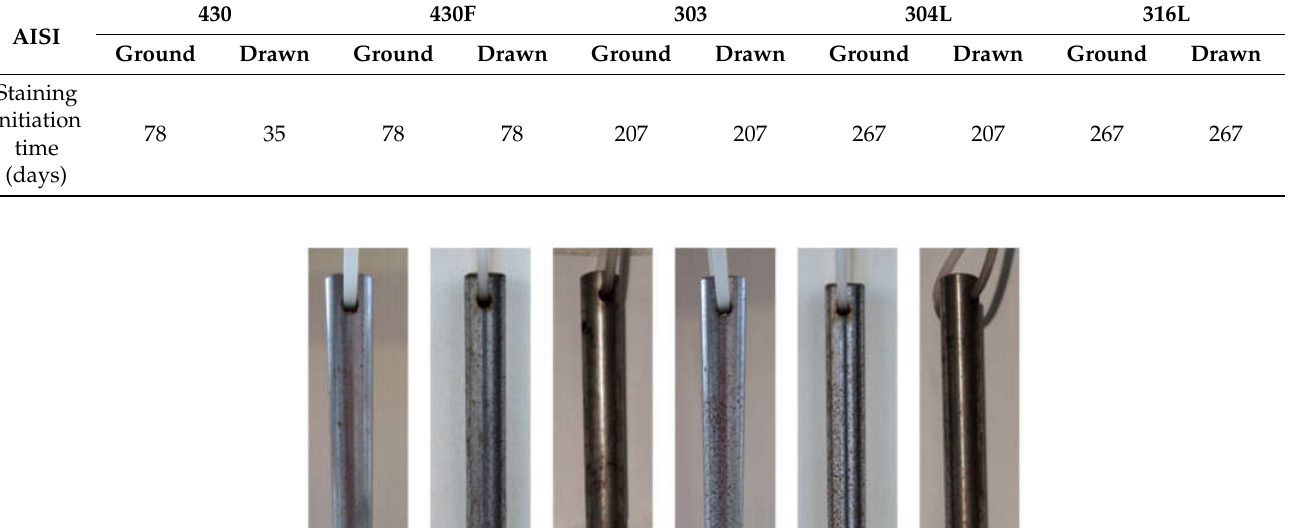
Table 8. Results of visual inspection of specimens exposed to marine atmosphere.